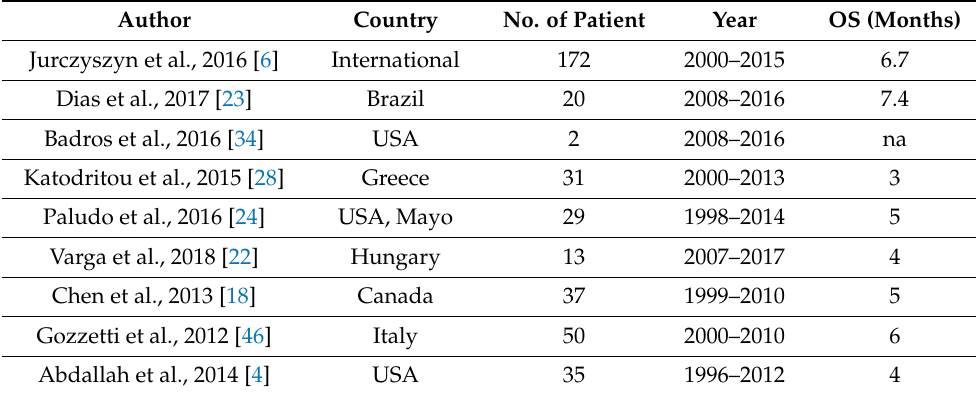
Table 2. Overall survival in patients with CNS involvement.